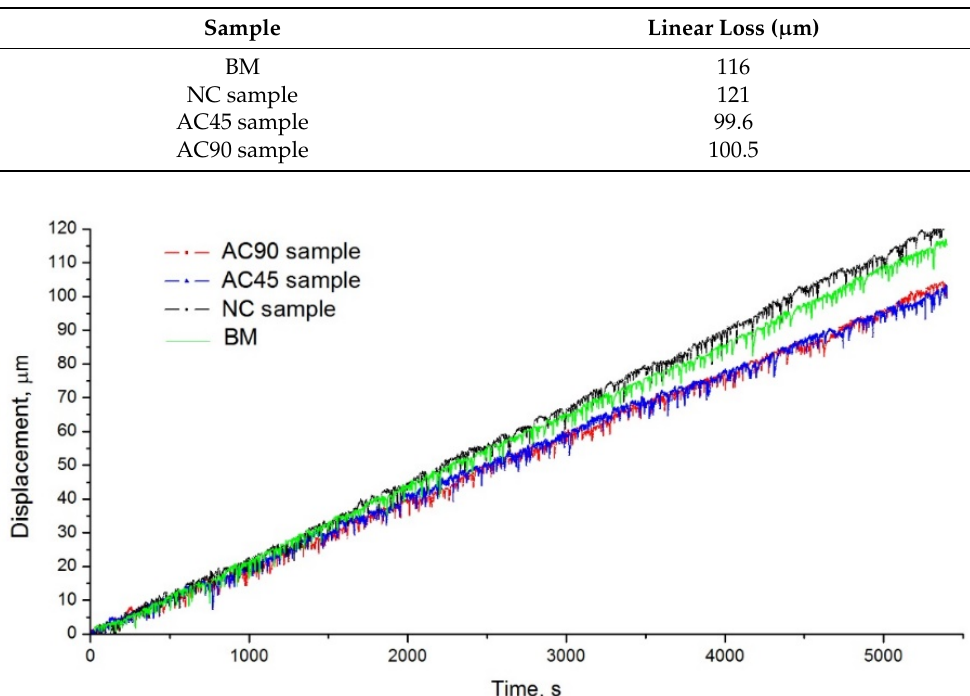
Table 7. Linear losses recorded during tribological test.